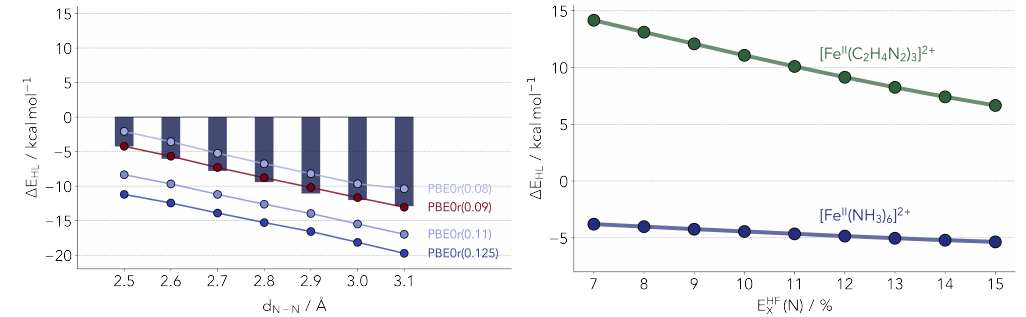
Figure 7. ( Left panel ) Comparison of ∆ E HL values computed with PBE0r. The numbers indicate the amount of exact exchange for all atom types. The bars depict the reference coupled cluster values. ( Right panel ) Comparison of the dependence of the ∆ E HL on the exchange